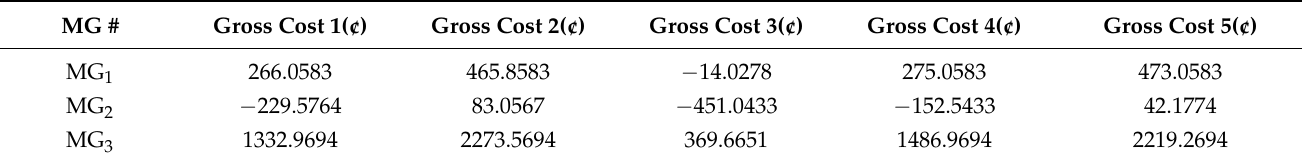
Table 10. Gross cost for five cases of scheduled load with fixed time slots with increased storage and RER size.